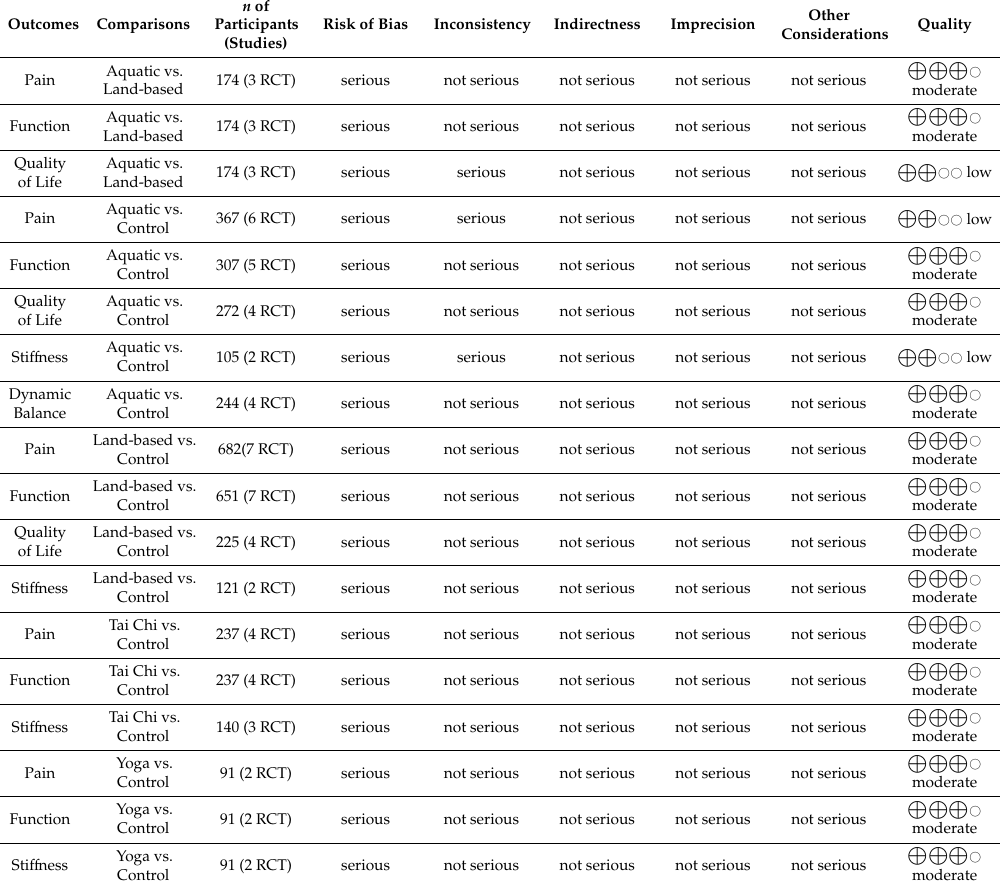
RCT: Randomized Clinical